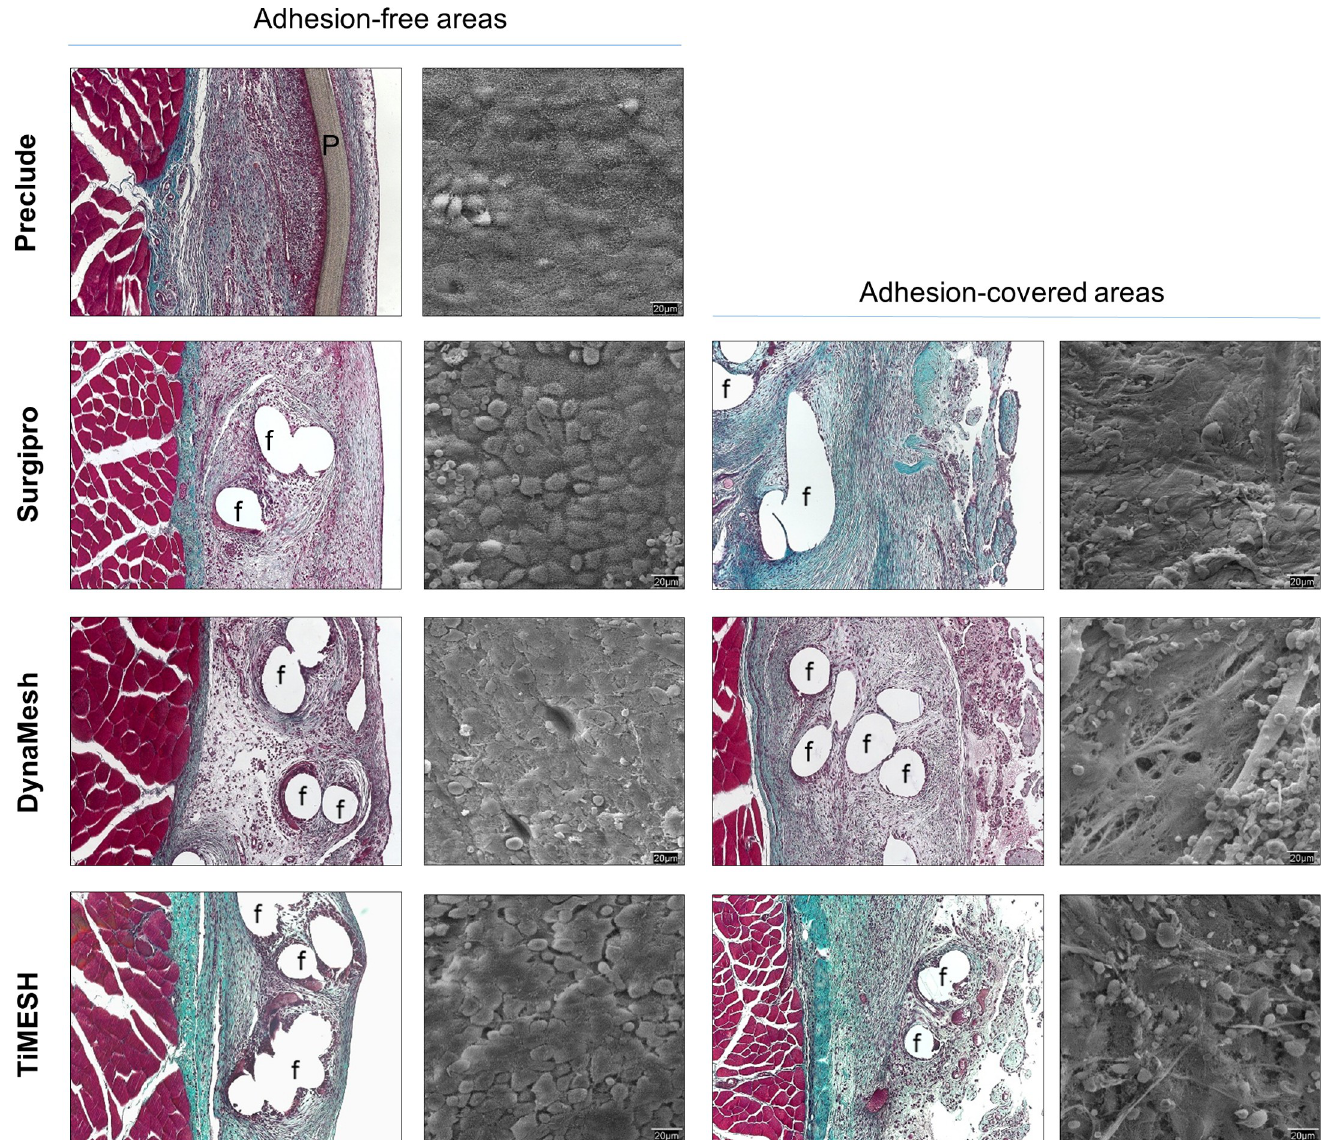
Fig 5. Morphological studies of the implanted meshes. Light microscopy (Masson´s trichrome staining, 100x magnification) and scanning electron microscopy micrographs of the surface of the materials (500x magnification) in adhesion-free and adhesion-covered areas for each group at 14 days post-implantation. The Preclude group showed no adhesion-covered areas in any animal. f: mesh filaments, P: Preclude.